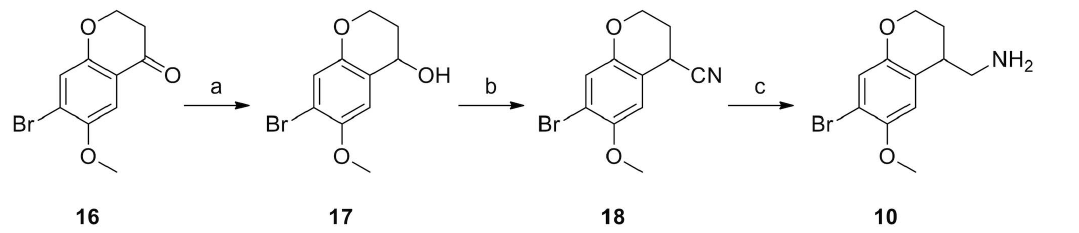
Figure 4. Synthesis of 10. Reagents and Conditions: (a) NaBH 4 , EtOH, r.t., 2 h; (b) Me 3 SiCN, BF 3 .Et 2 O, CH 2 Cl 2 , 2 78 u C to r.t.; (c) DIBALH, THF, reflux, 2 h. The 7-bromochroman-4-one 16 was prepared as previously